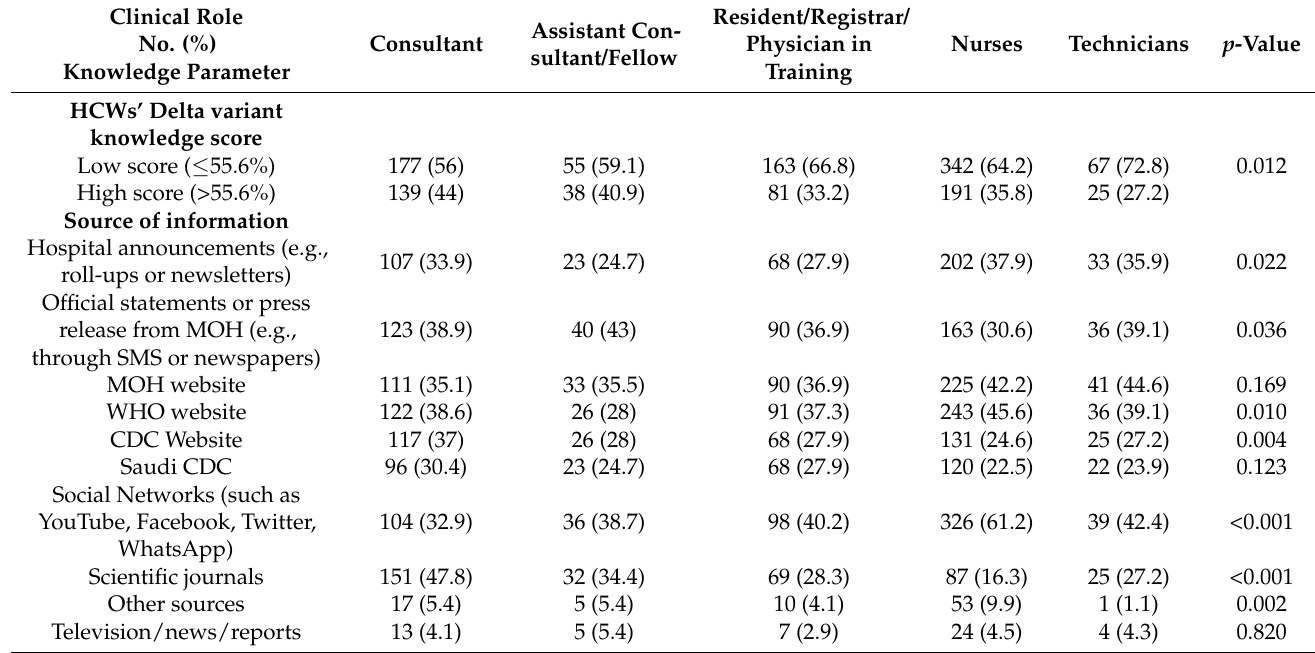
Table 6. Respondents’ Delta variant knowledge scores and sources based on their clinical